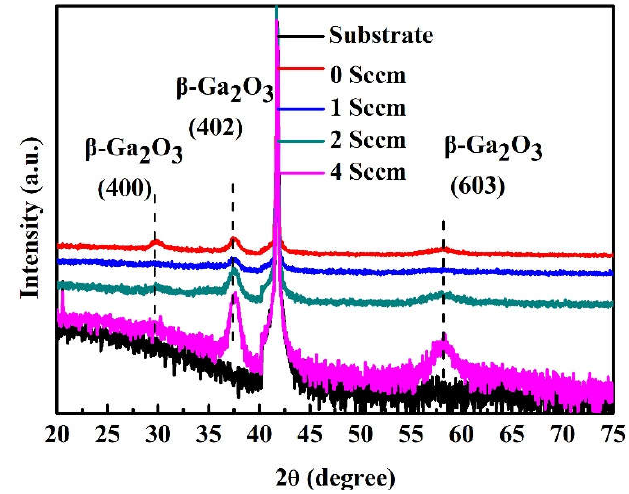
Figure 1. XRD patterns of Ga 2 O 3 films with various O 2 flow rates.